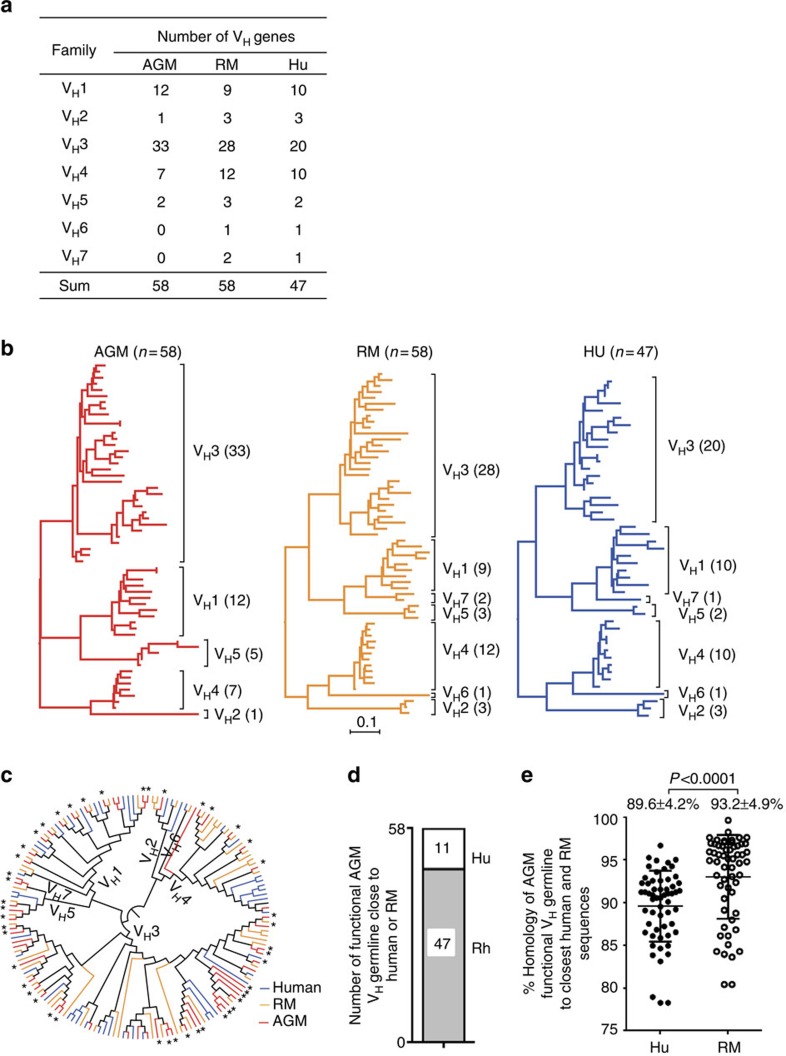
Genetic comparison of VH genes of AGM, RM and human.(b) Number of functional VH genes in three species. (b) Phylogenetic comparison of AGM (n=47), RM (n=58) and AGM (n=58) VH families. (c) Joint radial phylogenic trees of AGM (red lines), RM (orange lines) and human (green lines) VH genes. The AGM VH genes that are genetically more similar to RM (n=47) than human (n=11) VH homologues are highlighted with stars (*). (d) Number of AGM VH genes that are genetically more similar to human (white box) or RM (grey box) than the other species. (e) Percent homology of AGM VH genes to those of RM (empty circle, 93.2±4.9%) and human (filled circle, 89.6 ±4.2%; P<0.0001) were indicated and compared by an exact Wilcoxon rank sum test. The data in e shows means±s.d.